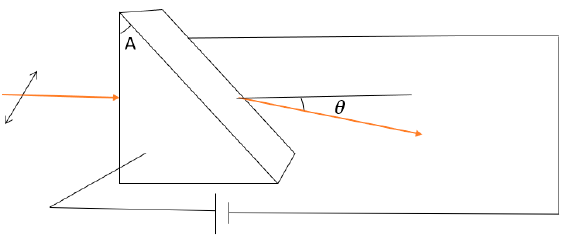
Figure 11. A triangular prism-shaped EO scanner. (W is the width, L is the length, and H is the height of the triangular prism).